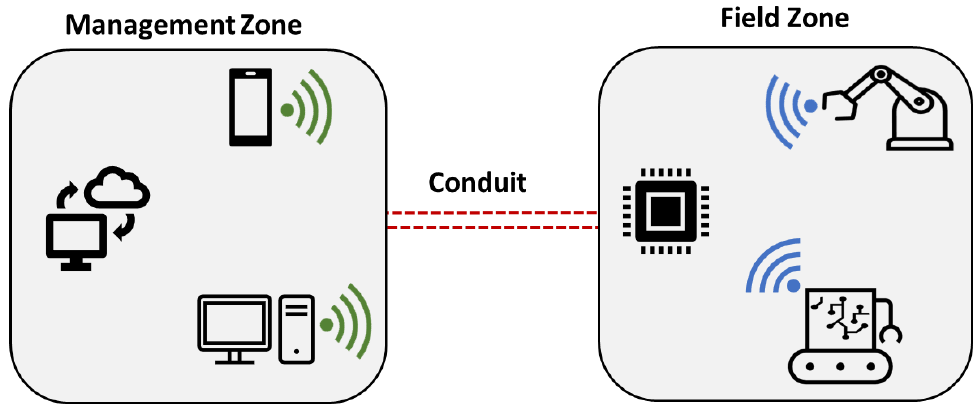
Figure 2. Example of SuC partitioning in zones and a